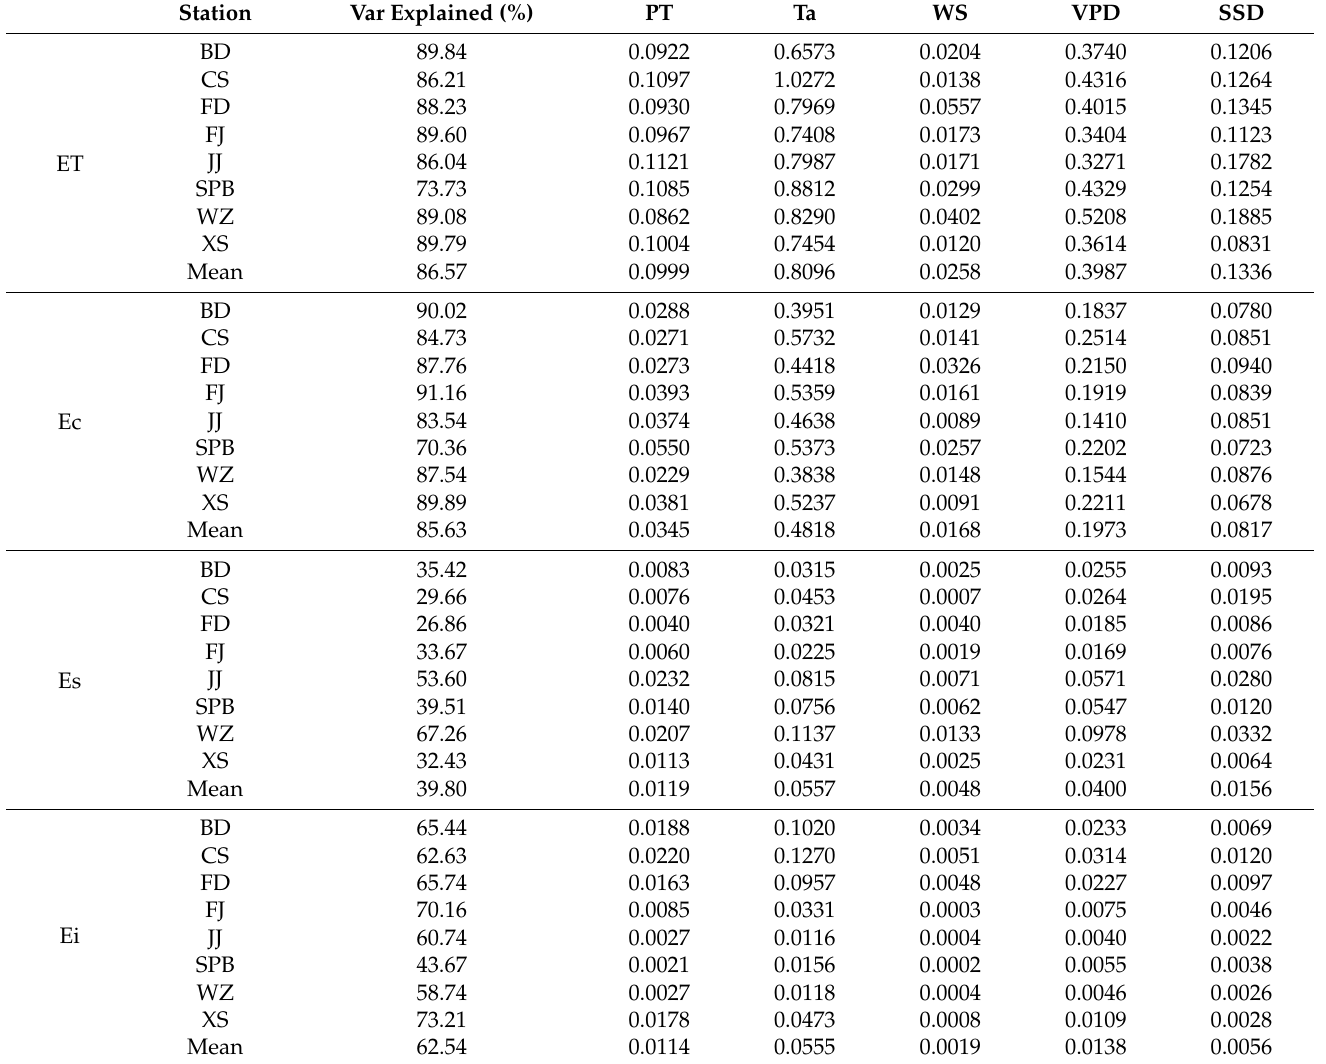
Table 3. Random forest results (the value of % incMSE) at different sites during